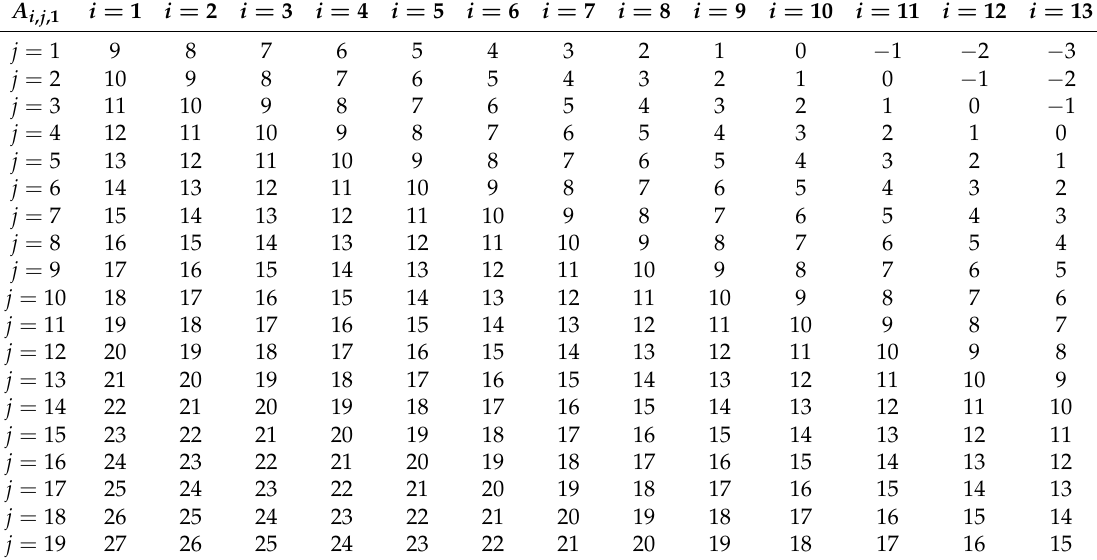
Table A2. Storage time of an assembly of OL1-2 belonging to the removal i ∈ I in the period j ∈ J A i , j ,1 .